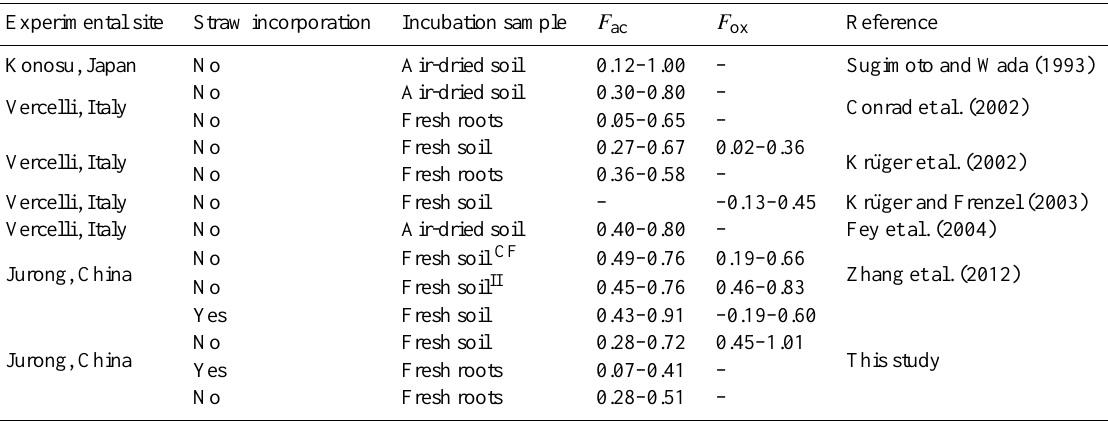
Table 5. Overview of the contribution of acetate-dependent CH 4 production ( F ac ) and the fraction of CH 4 oxidized ( F ox ) in paddy fields calculated with Eqs. (4) and